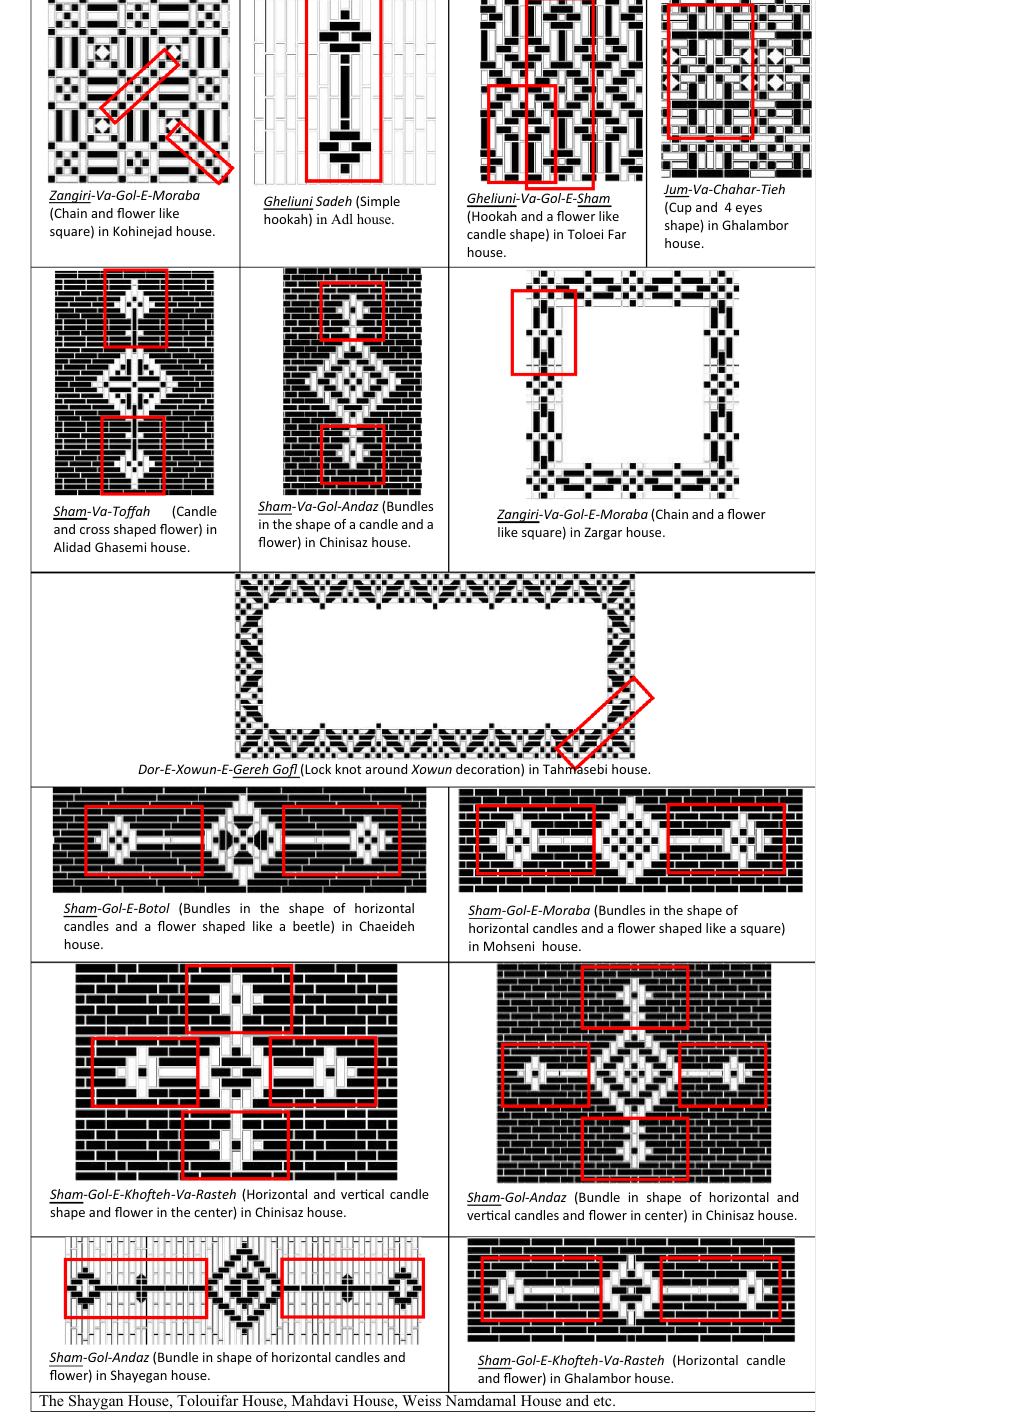
Table 1 The Xowun names in combined motifs (the name of the brick decoration is derived from architectural terms in the native